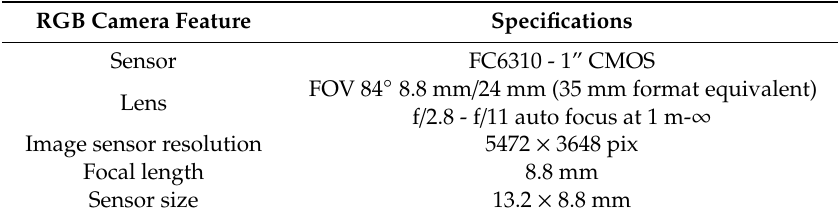
Table 2. Technical specifications of the camera sensor used for imagery acquisition.